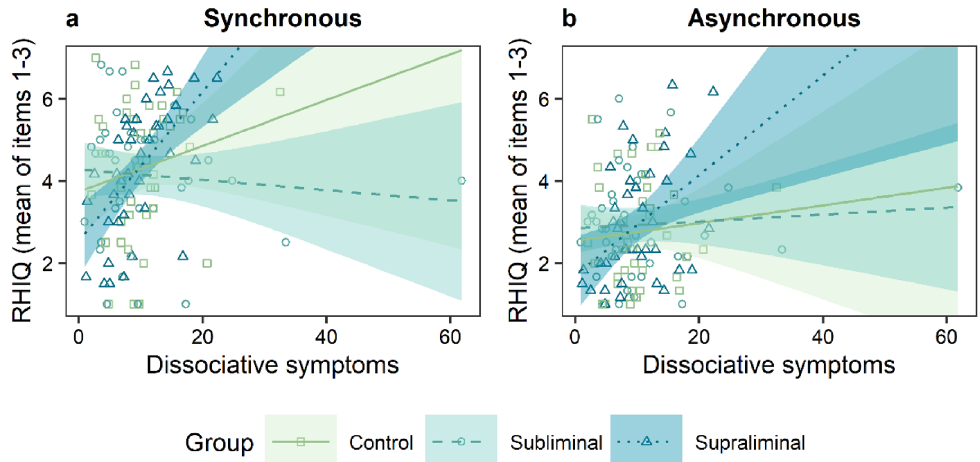
Figure 6. (a) Regression graph for the interaction effect of dissociative symptoms and group on the mean RHIQ scores, averaged across the synchronous trials. ( b) Regression graph for the interaction effect of dissociative symptoms and group on the mean RHIQ scores, averaged across the asynchronous trials. Linear fitting was performed separately for each